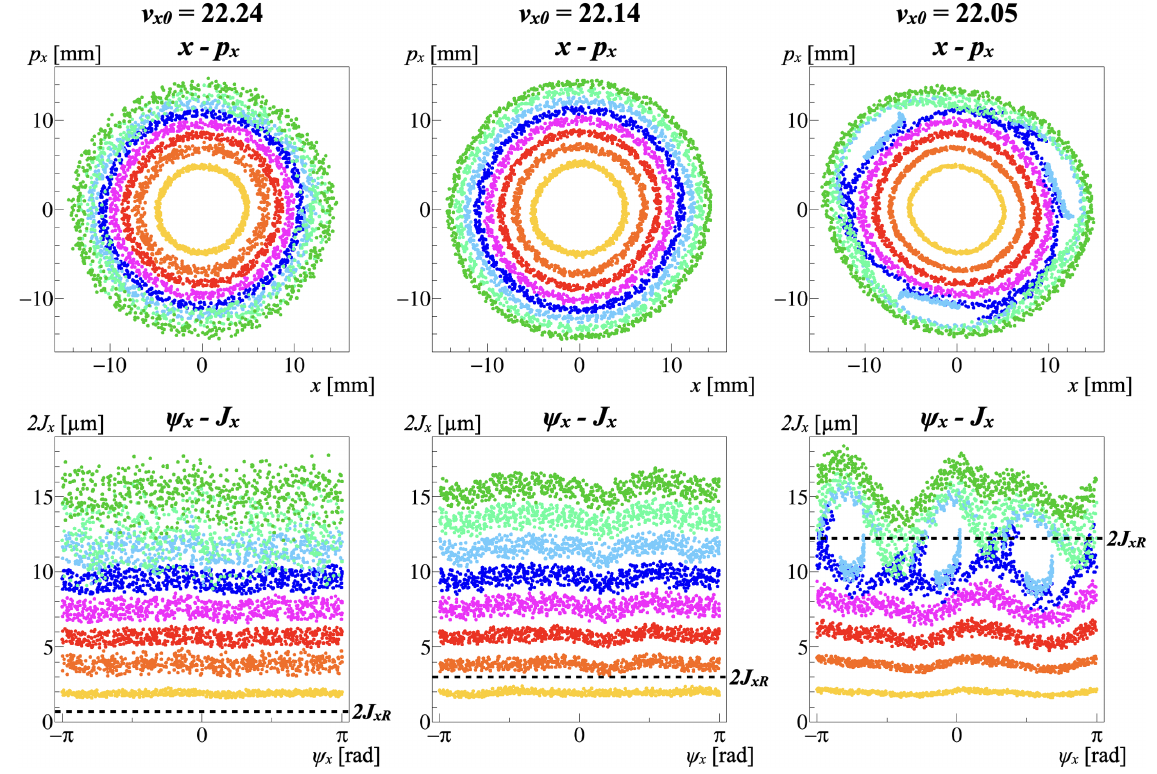
FIG. 11. Poincar´e maps obtained from SCTR calculations using the frozen model. The left panel corresponds to ν x 0 ¼ 22 . 24 , the center panel to ν x 0 ¼ 22 . 14 , and the right panel to ν x 0 ¼ 22 . 05 . The top row shows the Poincar´e maps of the normalized phase-space coordinates and the bottom row shows those of the action-angle coordinates. The same colors represent the same action in all plots. The black dotted lines in the bottom row represent the actions which meet the resonance conditions calculated analytically.